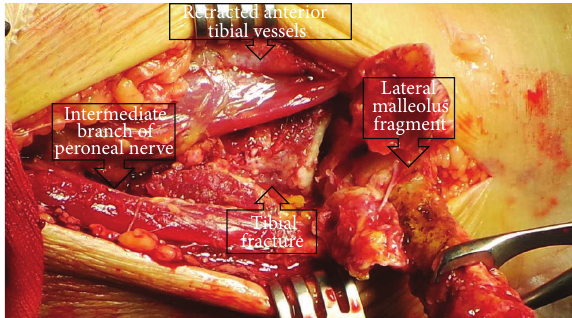
Figure 5: The lateral tibia is exposed via the transfibular approach. Note the proximity of the anterior tibial vessels and the deep peroneal